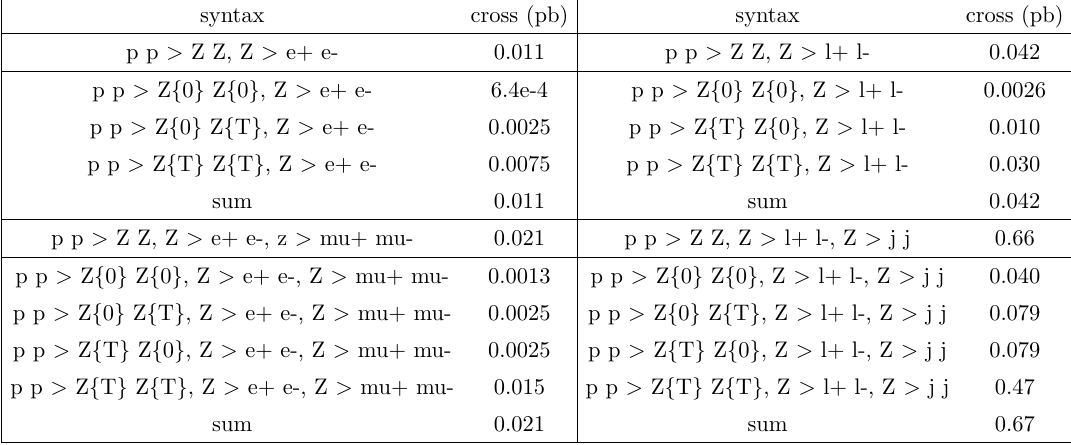
Table 7. Decomposition of the un-polarized sample into a sum of polarized samples. Depending of the syntax used one needs to sum either three or four di(cid:11)erent con(cid:12)gurations. The sample with the auxiliary/scalar component are here not included since they are